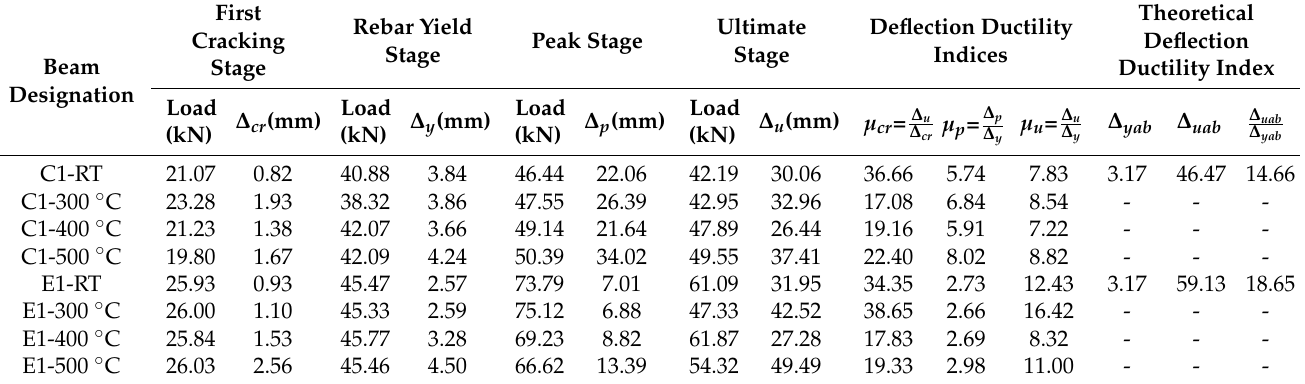
Table 9. The average deflection ductility indices of